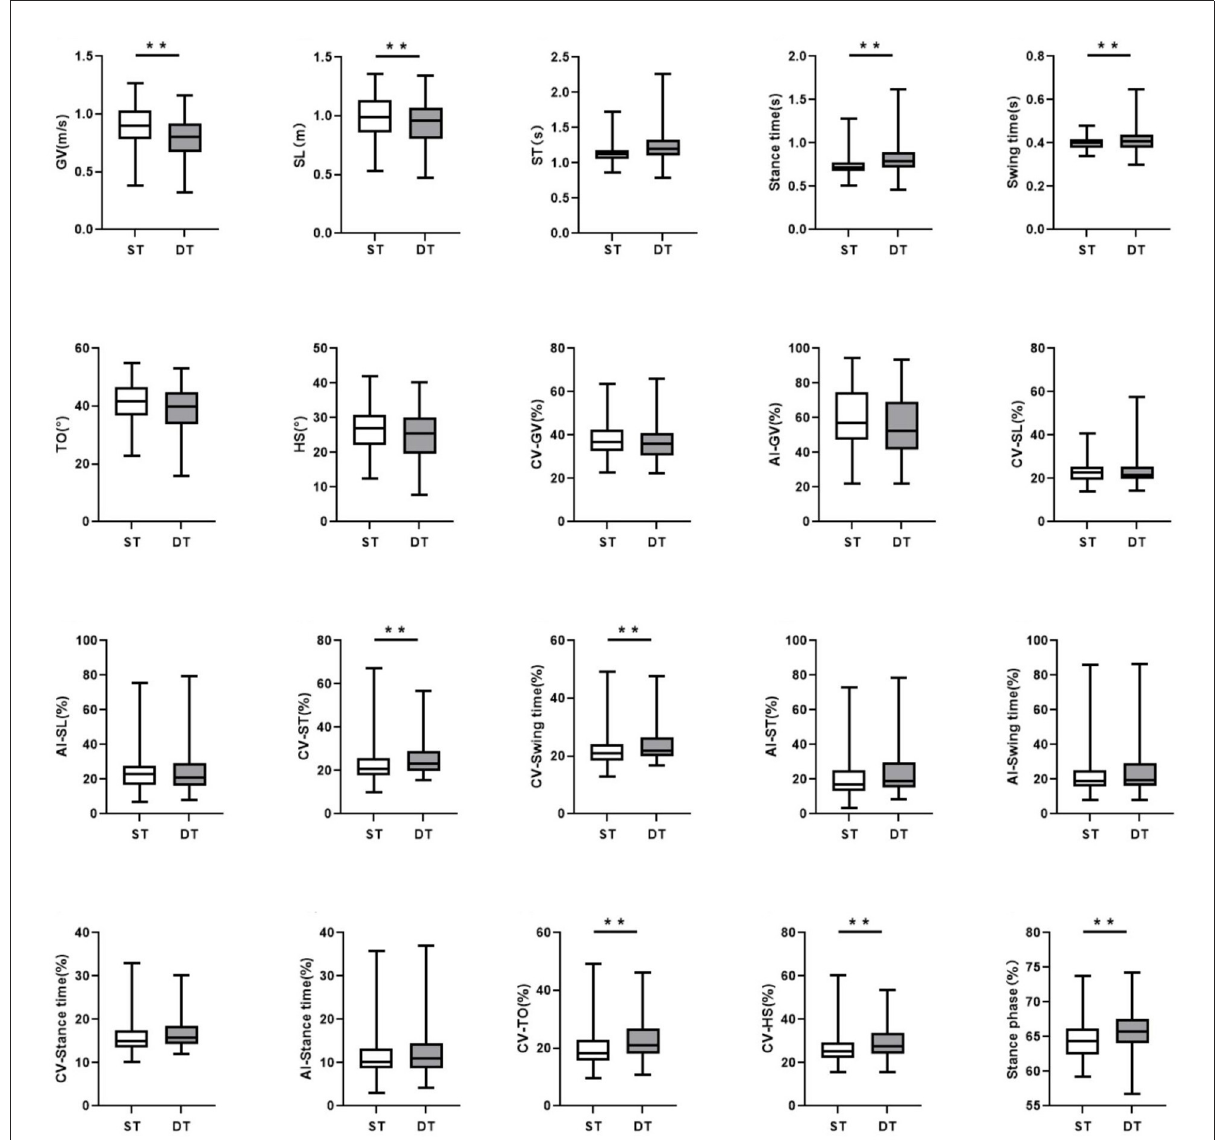
FIGURE1 The comparisons of gait characteristics of Parkinson’s Disease in single task walking and dual task walking. ST, single task; DT, dual task; PD, Parkinson’s Disease; HC, healthy control; GV, gait velocity; SL, stride length; ST, stride time; TO, toe-off angle; HS, heel strike angle; CV, coefficient of variation; AI, asymmetry index. All of the P-values were corrected using Benjamini–Hochberg multiple testing correction. ** p ≤